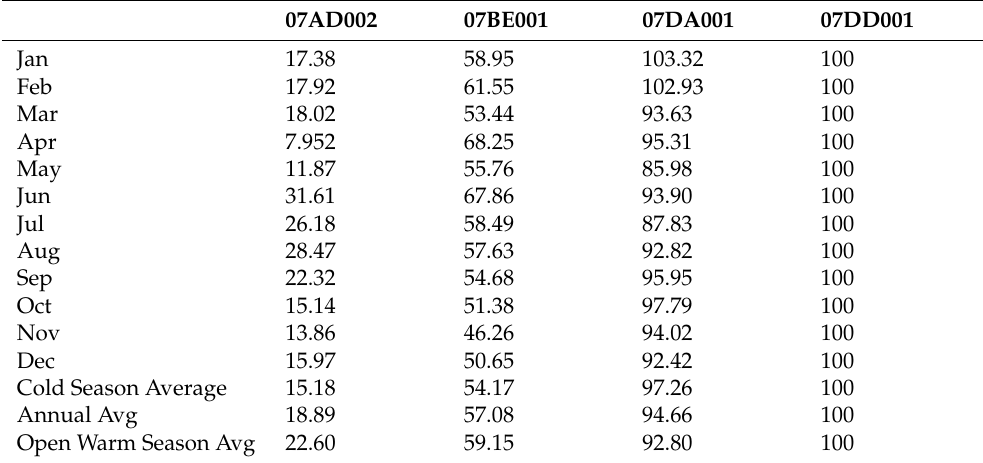
Table 6. Average flow at hydrometric stations at Hinton (07AD002, u3), Athabasca (07BE001, m6), and below Fort McMurray (07DA001, l2) as a percentage of flow at the outlet Embarras Airport (07DD001, l3) for the years 1972, 1973, and 1975.